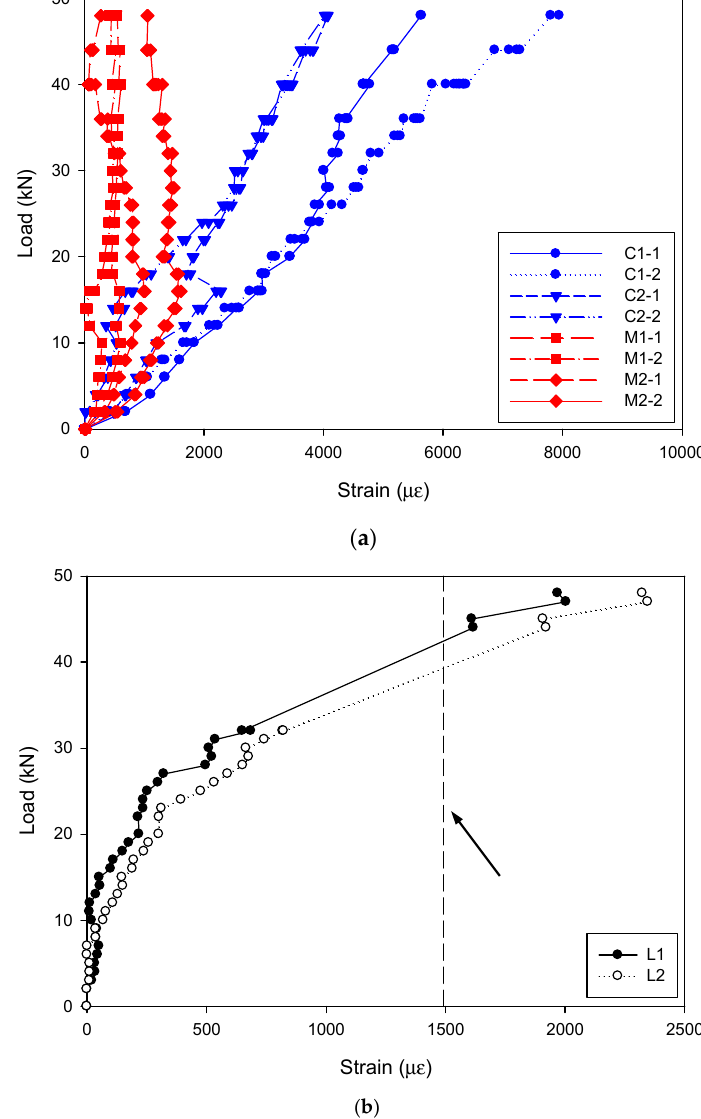
Figure 5. Typical load-strain curves of the specimen D150-40: ( a ) Strain gauges on the GFRP tube (compression); ( b ) strain gauges on the cross arm (tension).